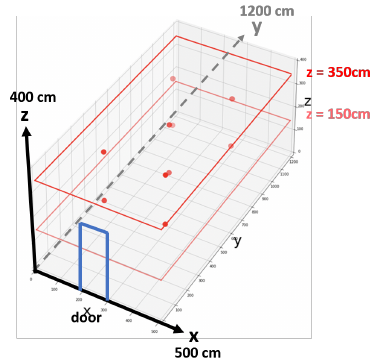
Figure 6. Smart Green House